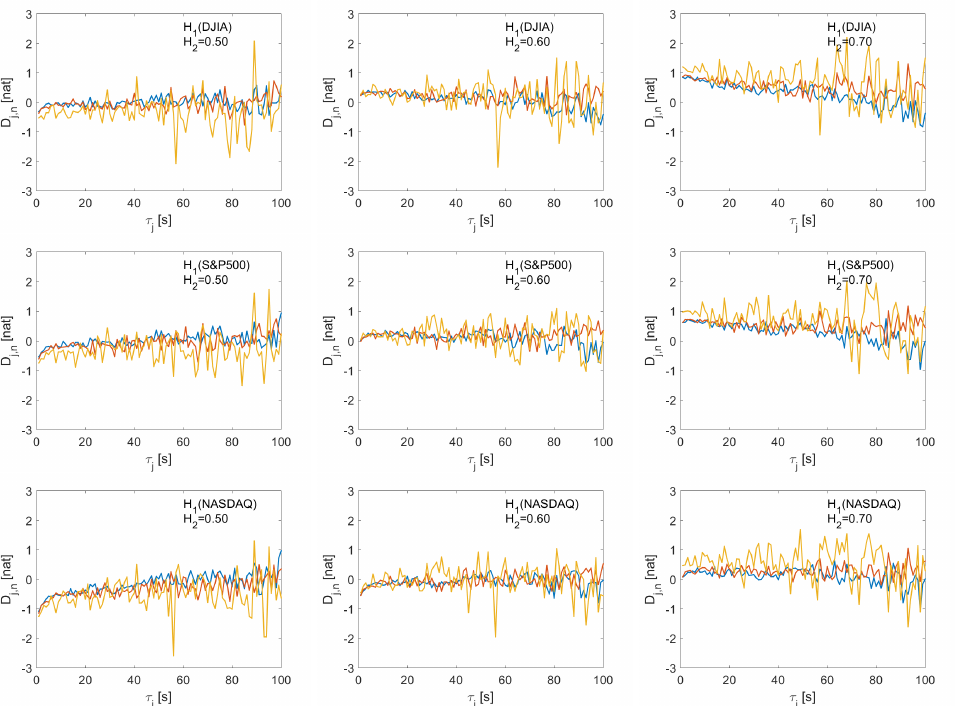
Figure 2: Plot of the quantity D , defined by Eq. (4), vs. cluster duration τ j , n cluster frequency P ( τ , n ) has been estimated on the clusters generated by the prices j of the DJIA, S&P500, NASDAQ indexes. The model probability Q ( τ estimated on the clusters generated by a f Bm with Hurst exponent H 0.50 to 0.70 and length N = 492023 equal to the length of the sampled indexes data. Different curves in each graph refer to different values of the parameter n (respectively n = 50 blue; n = 100 orange; n = 1000